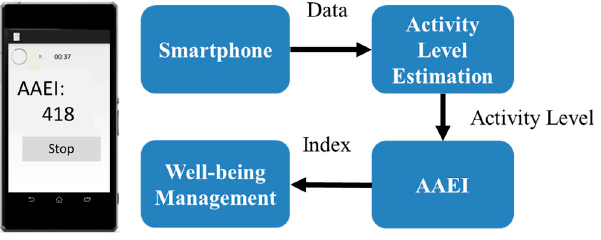
Figure 1. Function diagram of the exercise performance measurement system.